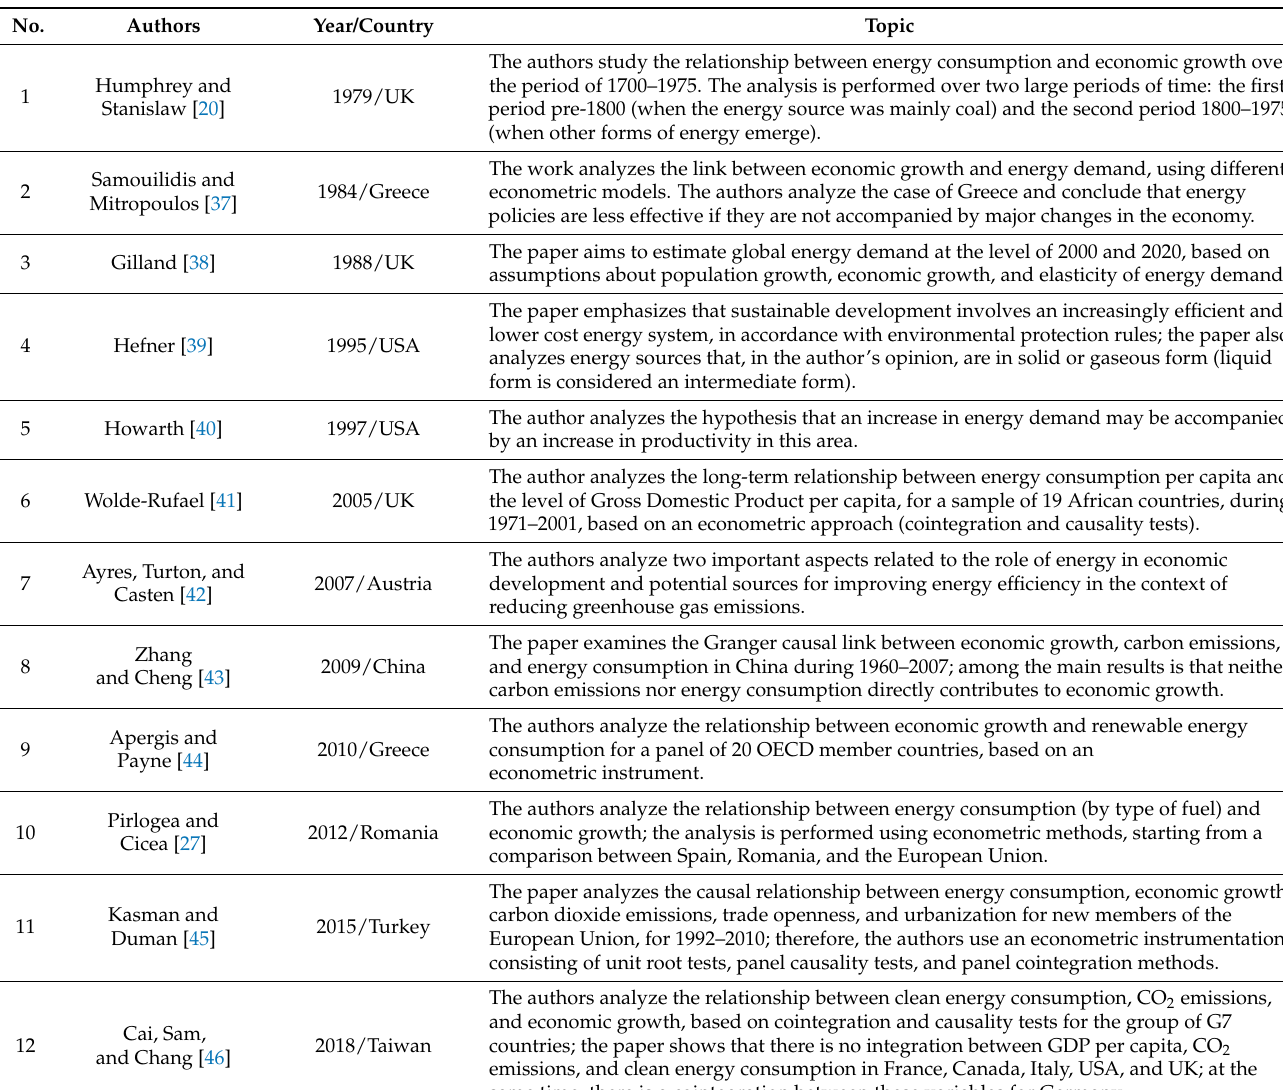
Table 1. Representative papers that focus on the energy–economic growth